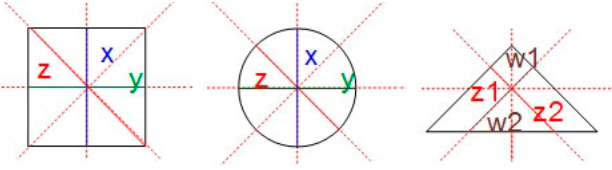
Figure 1. Parameters for form identification.